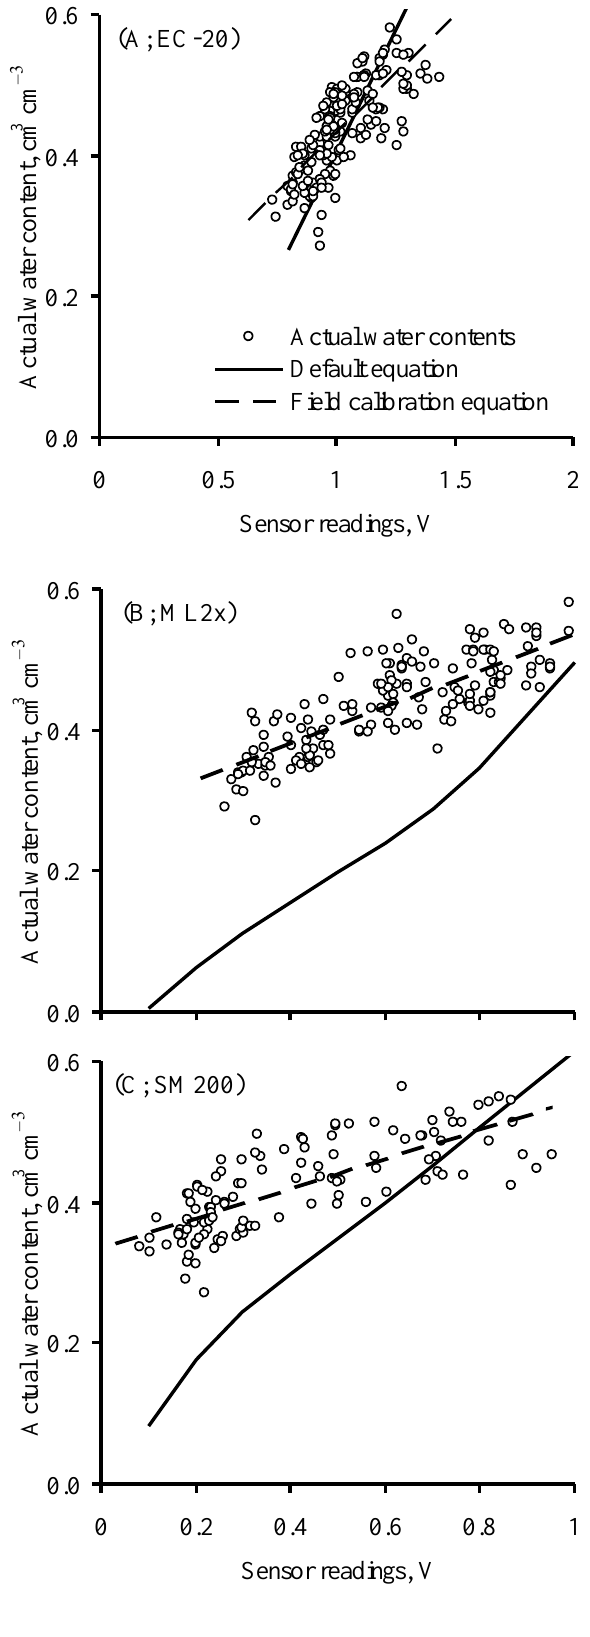
Figure 4. Field measured actual volumetric water content versus sensors’ readings plotted with default and site-specific field calibration models for ( A ) EC-20; ( B ) ML2x; and ( C )